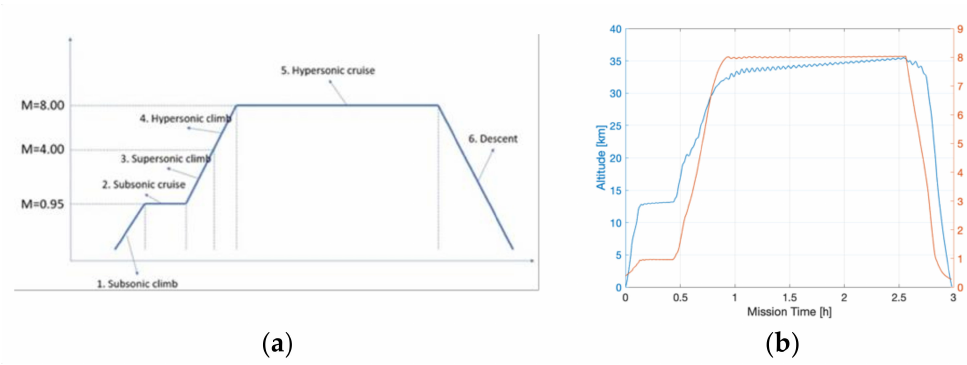
Figure 2. ( a ) STARTOFLY MR3 mission profile; ( b ) STRATOFLY MR3 flight altitude (light blue) and Mach number (orange) versus mission time.